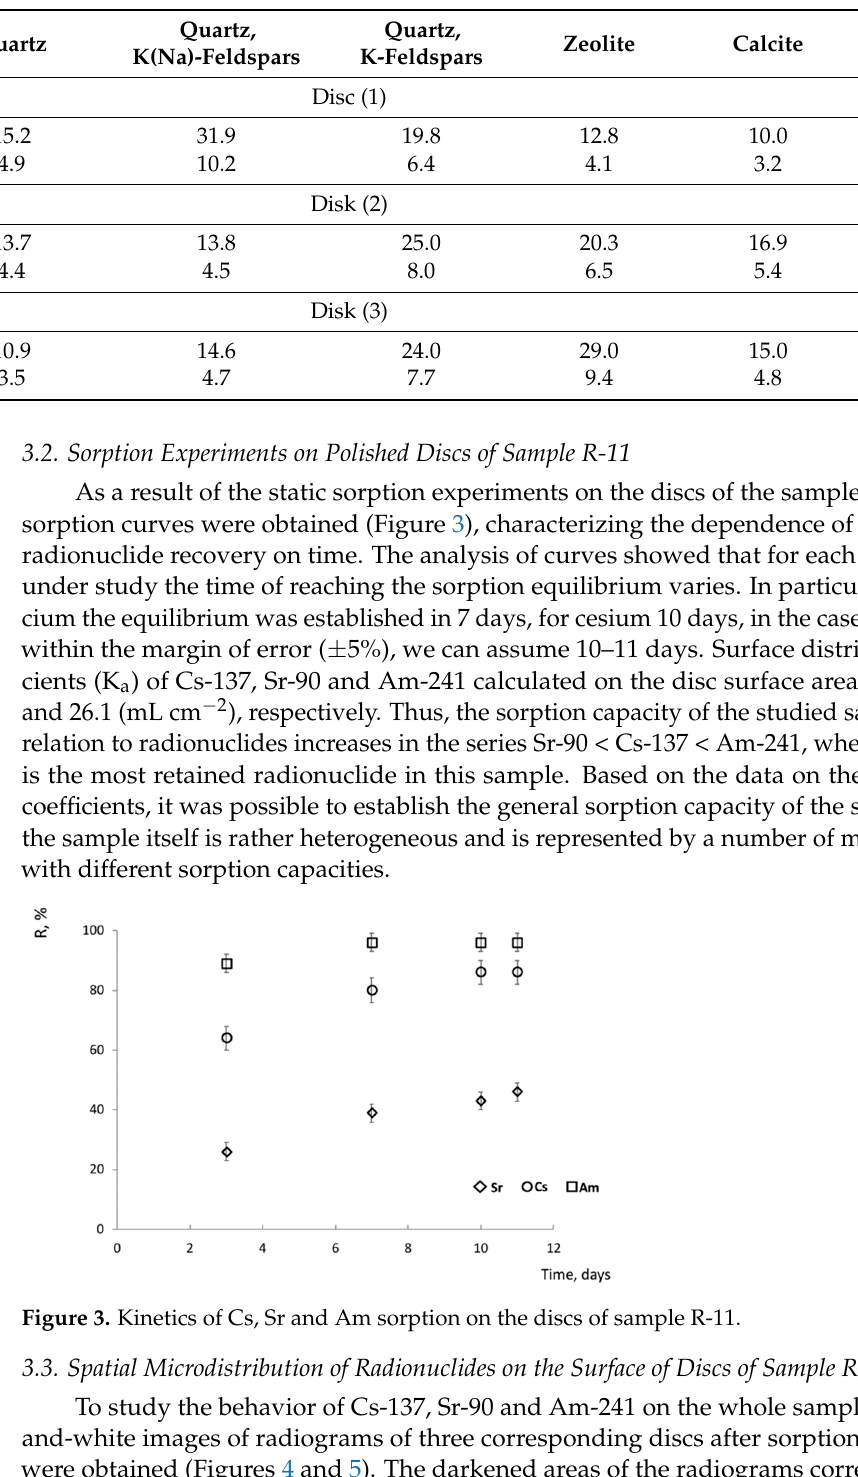
Table 2. Determination of the part of the area occupied by individual mineral phases on the surface of discs of the R-11 sample using the ENVI program.